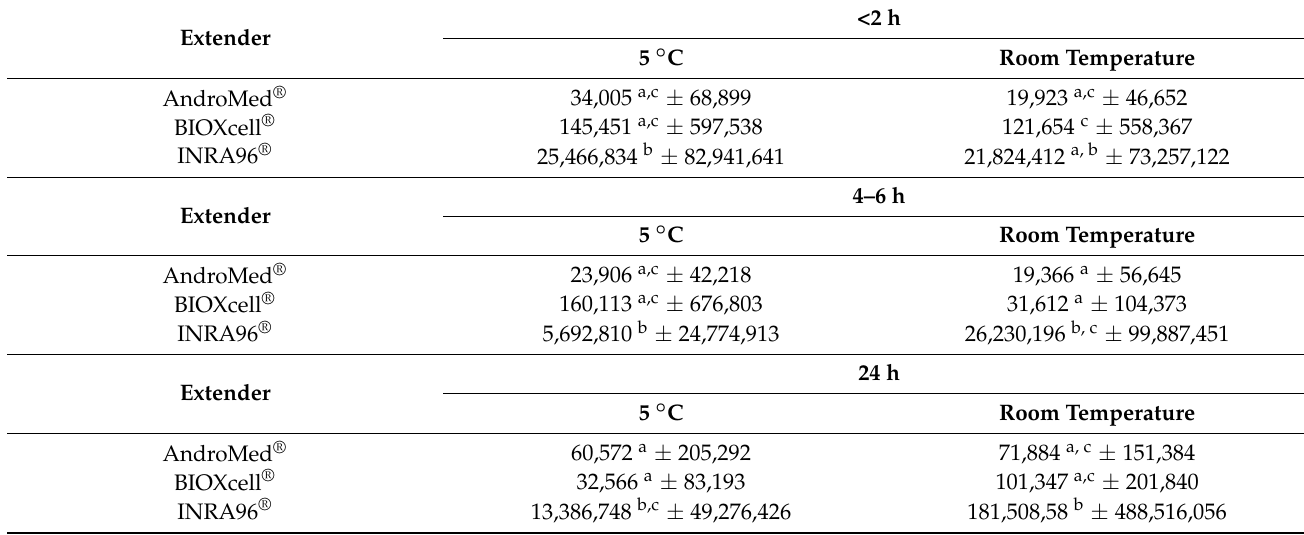
Table 1. Colony-forming units (CFUs) for semen samples, stratified by extender, storage duration, and storage temperature.